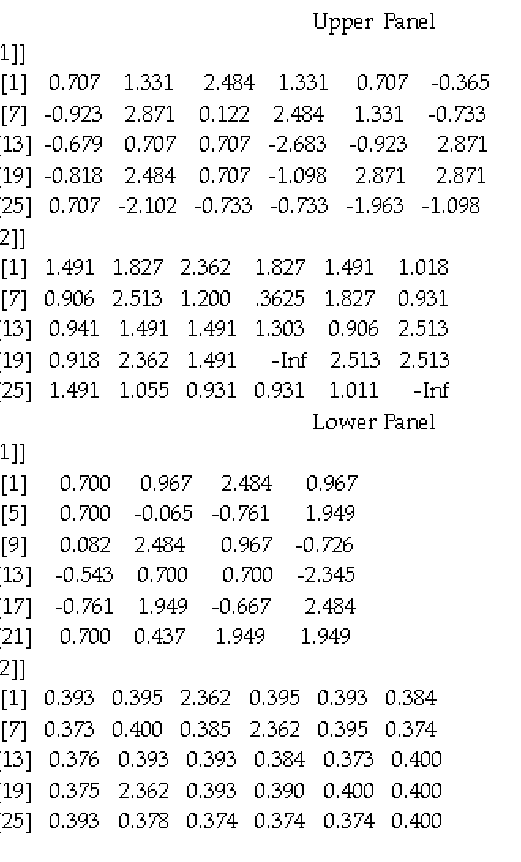
Figure 1. Estimates of theta and standard error for a sample of participants using MLE (upper panel) and BME (lower panel).